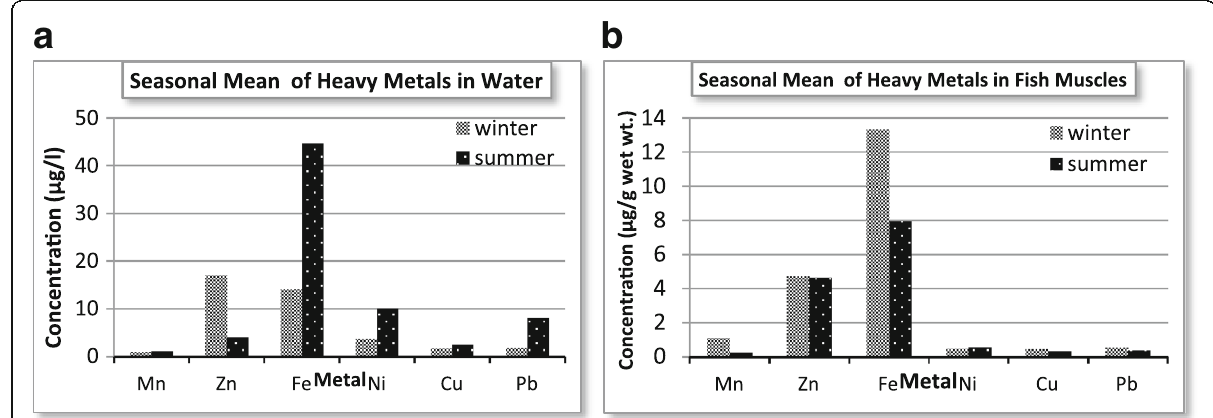
Fig. 4 Seasonal mean of heavy metals in a water ( μ g/L) and b in O. niloticus muscles ( μ g/g wet wt.) from Burullus Lake during winter and summer